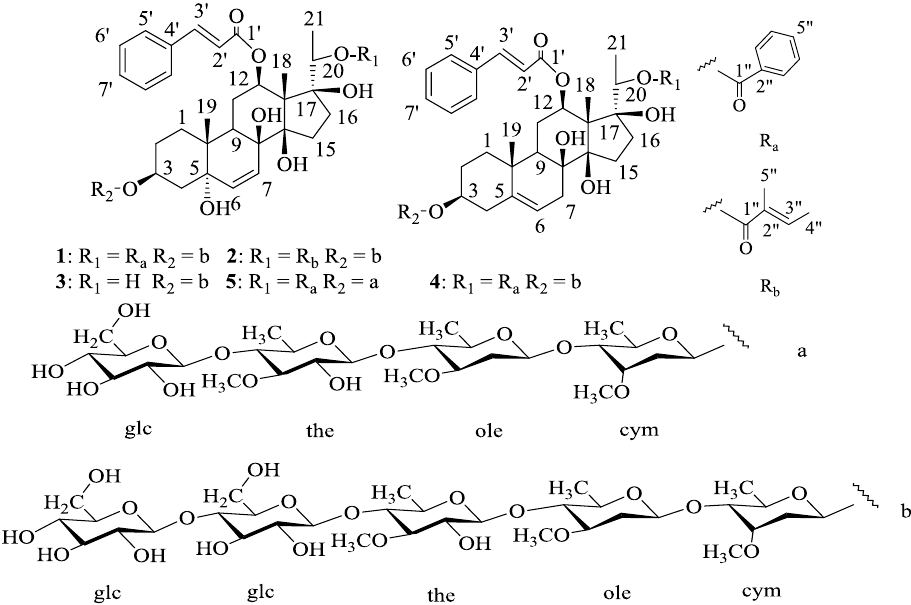
Figure 1. Structures of compounds 1 – 5